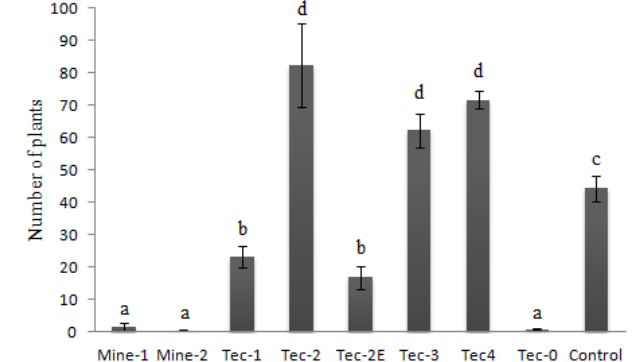
Figure 2. Number of individuals (mean ± SE) at day 73. Di ff erent letters above bars mean significant di ff erences between each soil type after non-parametric tests.